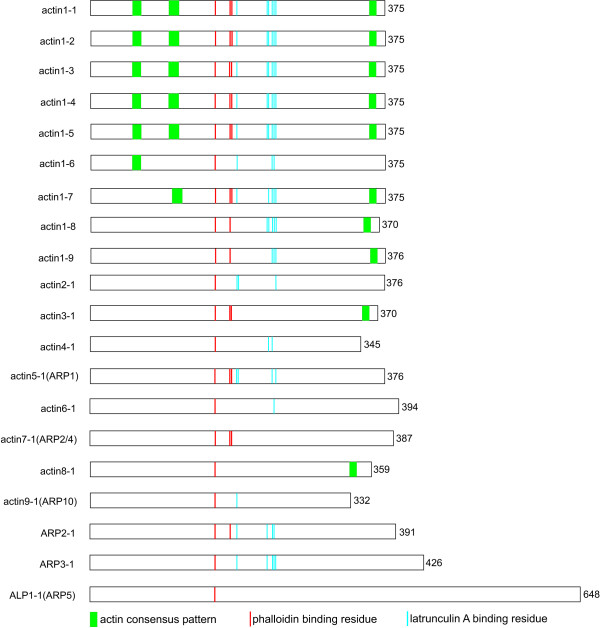
Characteristic features of P. tetraurelia actins, ARPs and ALP. Characteristic features include consensus and drug binding motifs. These are identical within subfamilies wherefore only one isoform of each is shown as an example. The actin signatures (green) are based on the three actin consensus patterns according to PROSITE: ACTINS_1, [FY]-[LIV]-G-[DE]-E-A-Q-x-[RKQ](2)-G; ACTINS_2, W-[IV]-[STA]-[RK]-x-[DE]-Y-[DNE]-[DE] and ACTINS_3, [LM]-[LIVM]-T-E-[GAPQ]-x-[LIVMFYWHQ]-N-[STAQ]-x(29-N-[KR]. Not all isoforms contain the typical consensus pattern found in most of the actin genes described in other species. Also the three residues mediating the binding of phalloidin (G158, R177 and D179) are not present in every subfamily (red). The same is true for the residues (blue) relevant for the binding of latrunculin A (D157, R183, D184, R210, D211, K213, E214 and K215).